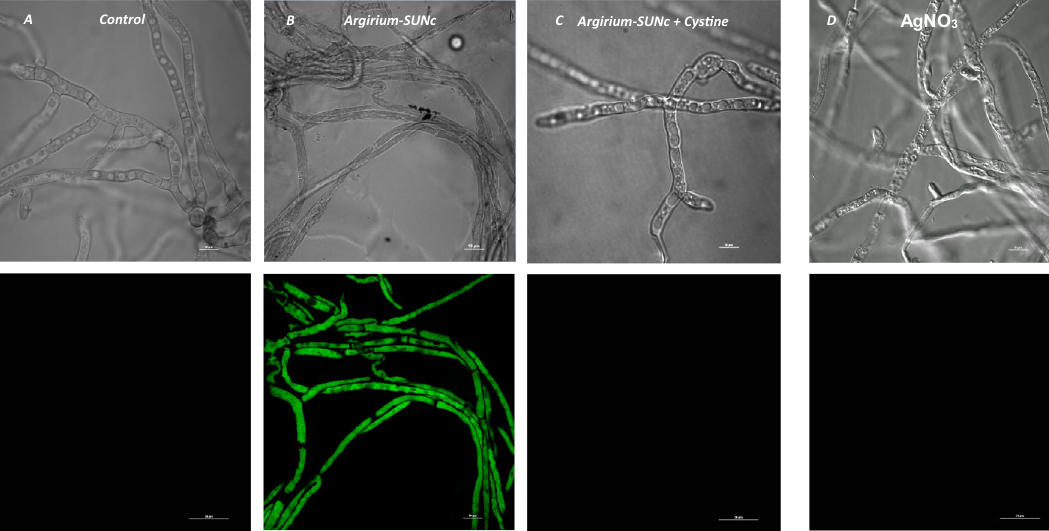
Figure 3. Effect of Argirium-SUNCs on cellular membrane depolarization. Hyphae of A. niger GM31 were stained with 20 μg/ml of DiBAC4 (Bis-(1,3-Dibutylbarbituric Acid Trimethine Oxonol). ( A ) Untreated hyphae; ( B ) hyphae treated with 0.625 mg L −1 Argirium-SUNCs ; ( C ) Hyphae treated with Argirium-SUNCs + Cystine and ( D ) Hyphae treated with AgNO 3 . Scale bar of 20